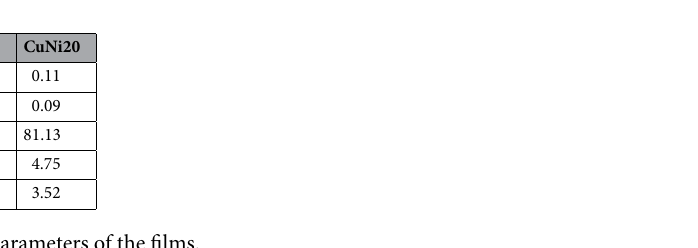
Table 4. Surface microtexture parameters of the